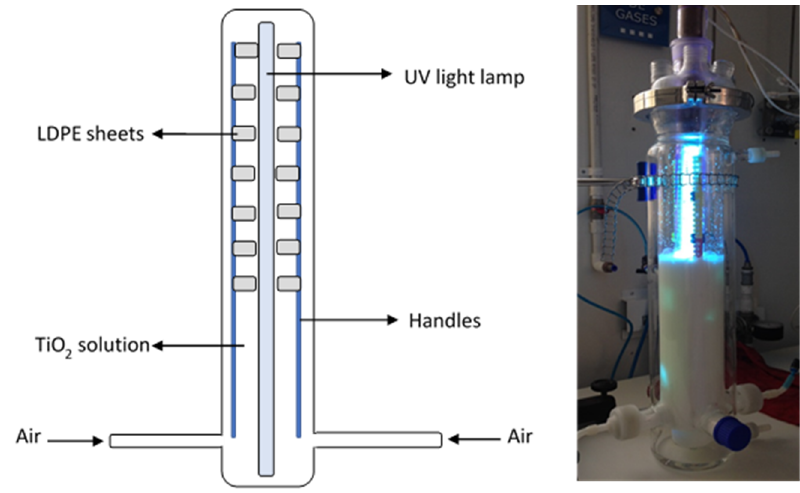
Figure 10. Photoreactor’s assembly for the photocatalysis